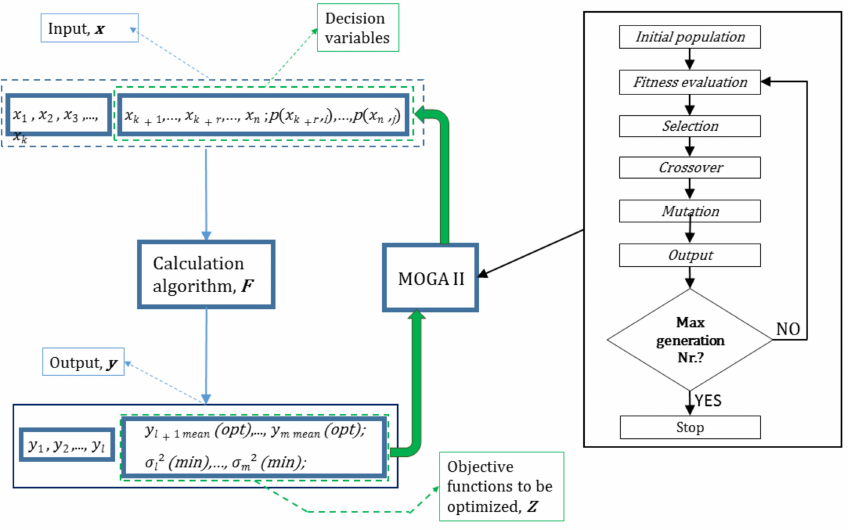
Figure 4. Workflow of the multi-objective optimization